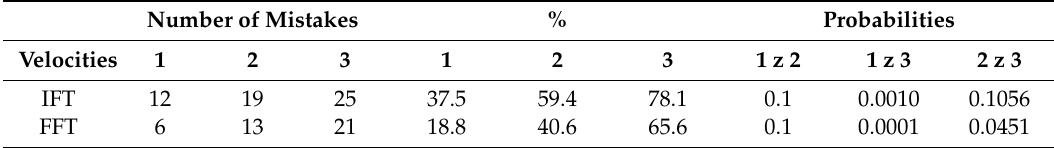
Table 1. Comparison with t-Student’s test of error percentages between speeds for group A ( n = 32) and for each immediate fall test (IFT) and forced fall test (FFT), separately for ‘head’ mistake.